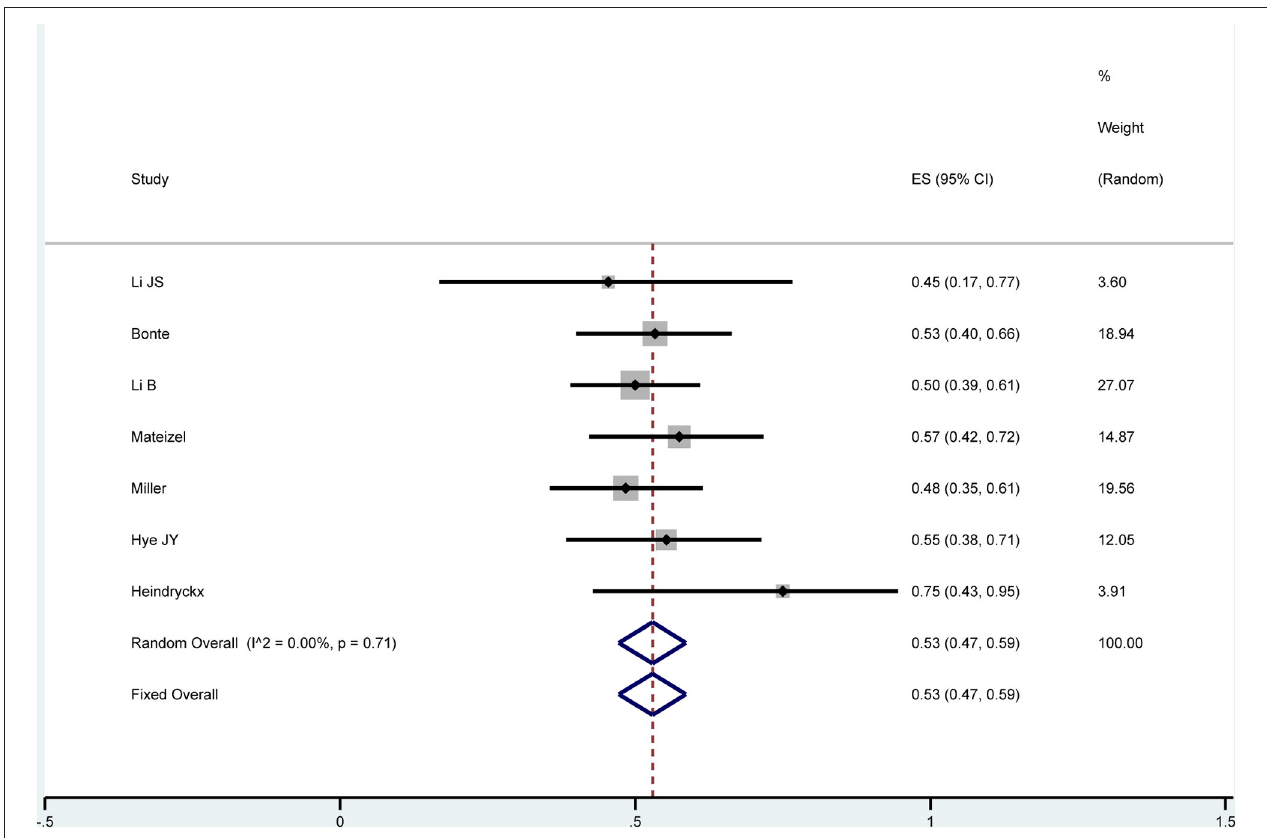
FIGURE 11 | Forest plots of the included studies reporting data on sex